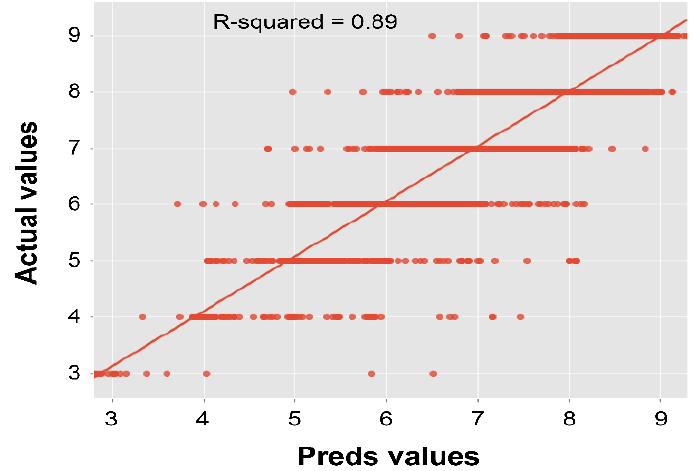
Figure 2. Test coefficient of the determination analysis for the deck condition model.